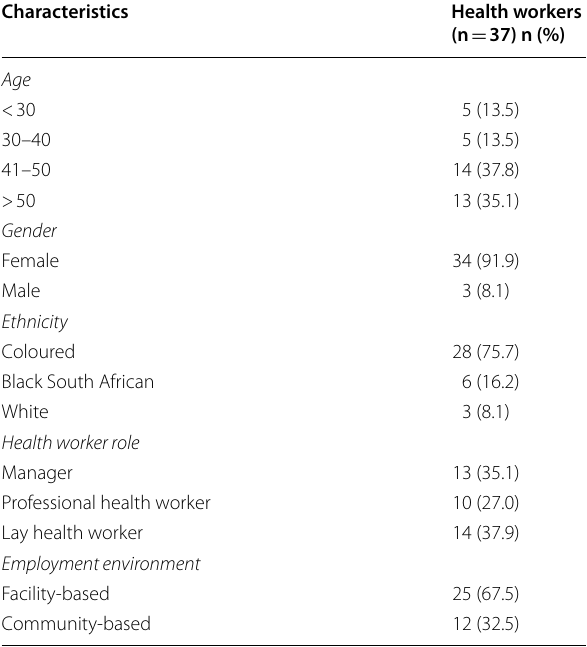
Table 2 Demographic and occupational characteristics of